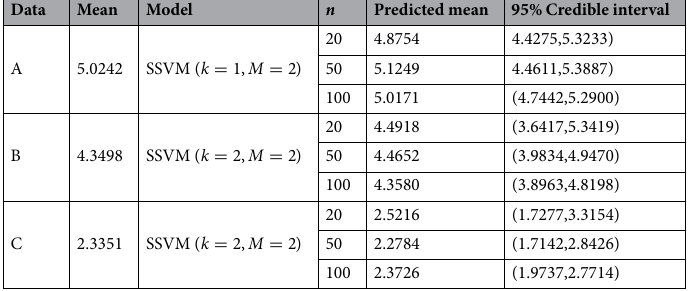
Table 6. Predicted wind direction based on absolute error loss function for different values of n